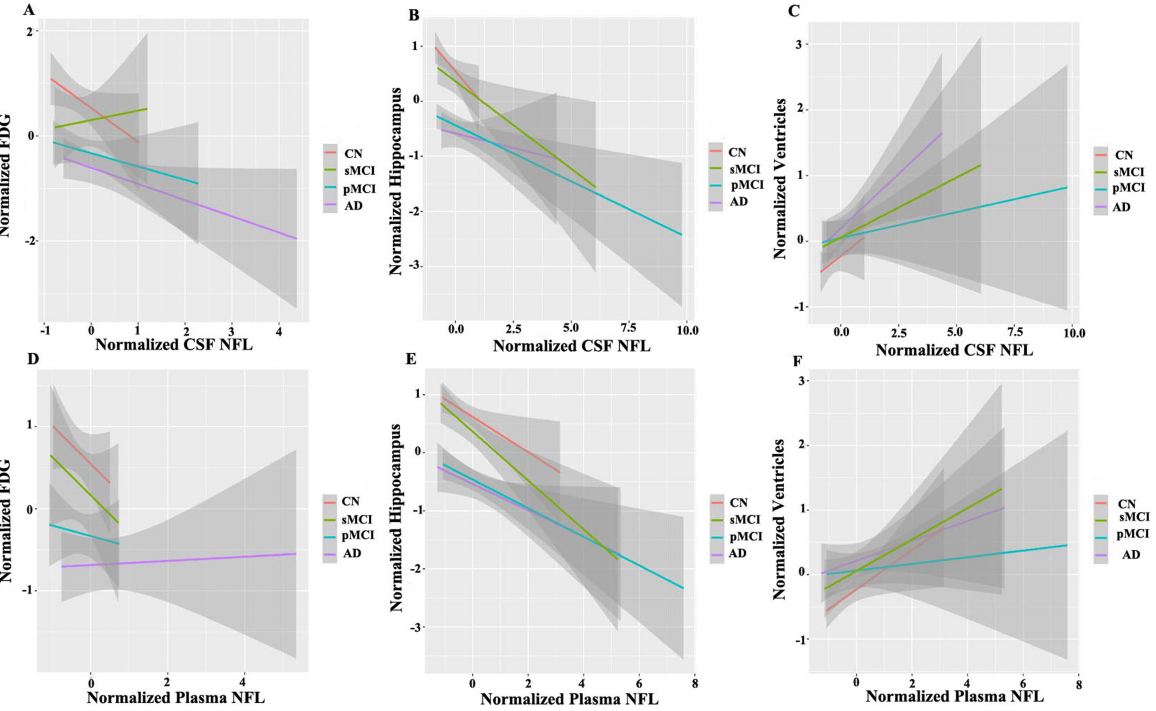
Fig. 7. CSF and plasma NFL in relation to baseline metabolism and brain structure. FDG (A), hippocampal volumes (B), and ventricular volumes (C) at baseline as a function of baseline CSF NFL in different groups. FDG (D), hippocampal volumes (E), and ventricular volumes (F) at baseline as a function of baseline plasma NFL in different groups. Values of all indicators are